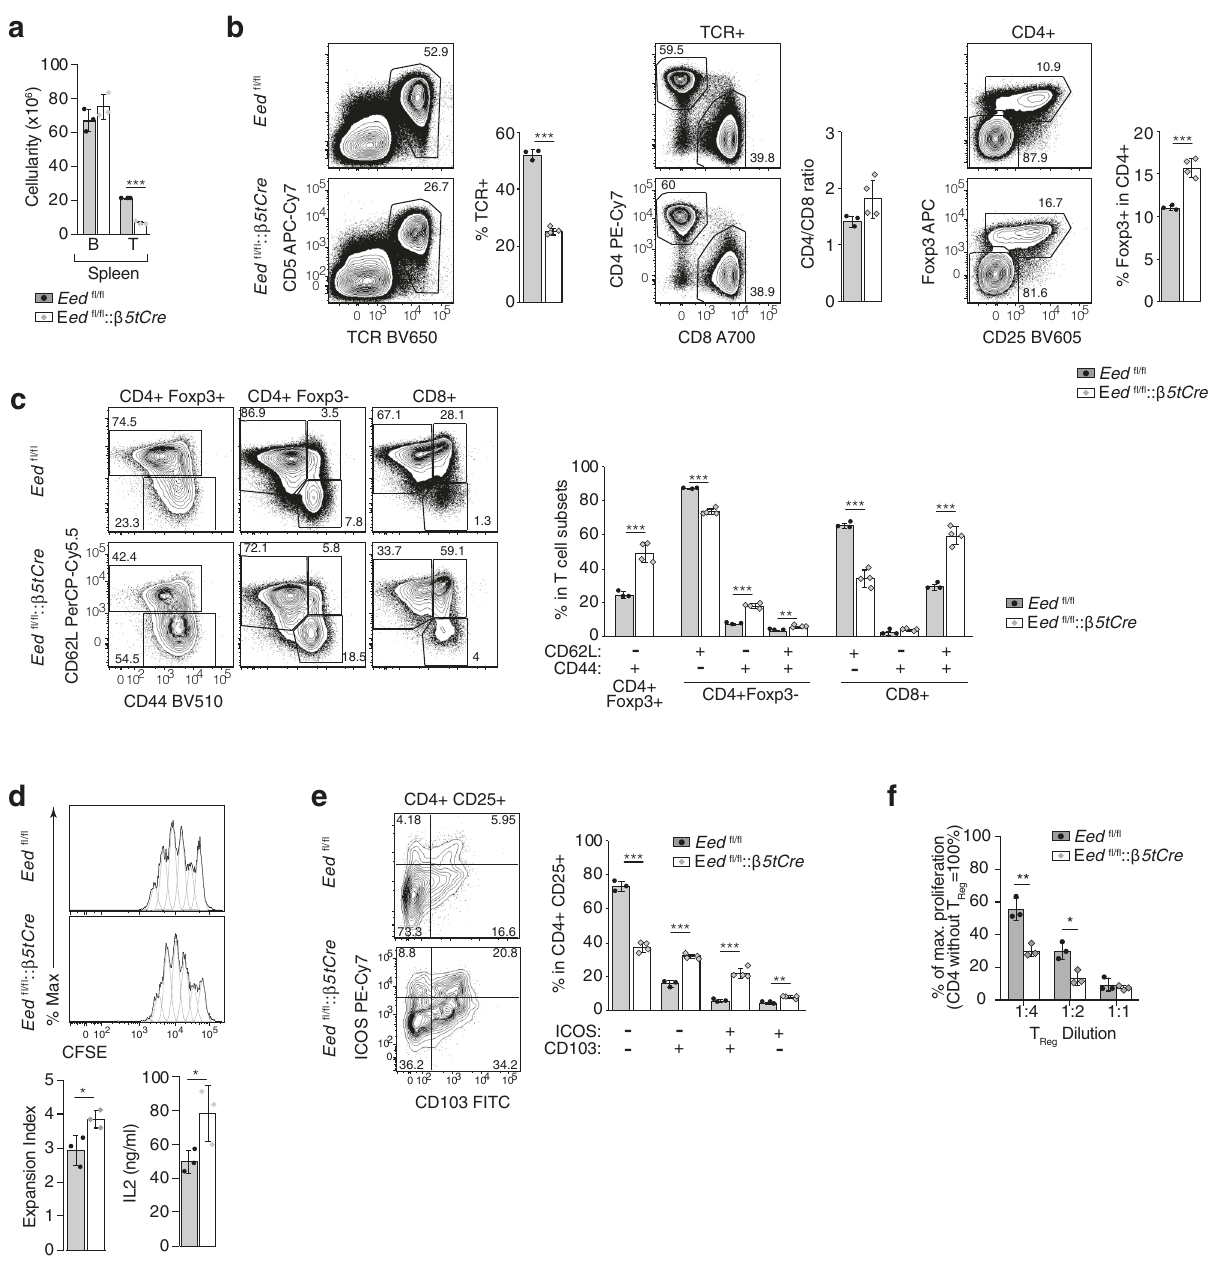
Fig. 6 Peripheral T cells and their function in Eed fl / fl :: β 5tCre and Eed fl / fl mice. a Absolute numbers of splenic B and T cells in Eed fl / fl ( n = 3) and Eed fl / fl :: β 5tCre mice ( n = 3) at 4 weeks of age. b Representative contour plots and frequencies of lymph-node-derived T cell subsets. Frequency of TCR β + T cells, the CD4/CD8 ratio within TCR β + T cells and percentage of Foxp3 + T Reg in CD4 T cells. c Frequencies of activated cells (CD44 + CD62L − ) in Foxp3 + T Reg and frequencies of naive (CD44 − CD62L + ), central memory (CD44 + CD62L + ) and effector memory (CD44 + CD62L − ) T cells within the populations of Foxp3 − CD4 and CD8 lymph node cells. b , c Eed fl / fl ( n = 3) and Eed: fl / fl : β 5tCre mice ( n = 4) at 4 weeks of age. d Proliferative response and IL-2 secretion of naive lymph node CD4 T cells (CD44 lo CD25 − ) from Eed fl / fl ( n = 3) and Eed fl / fl :: β 5tCre mice ( n = 3) at 4 weeks of age. Representative histograms of CFSE dilution (including model components used for expansion index calculations; grey dotted lines) following stimulation for three days with CD3 mAb (1 µ g/ ml) and irradiated Rag2 − / − splenocytes. Bar graphs display the mean expansion index (left) and mean IL2 concentrations in the supernatant (right) with SD. e Representative contour plots and frequencies of lymph-node-derived T Reg subsets de fi ned by their differential expression of ICOS and CD103 from Eed fl / fl ( n = 3) and Eed fl / fl :: β 5tCre mice ( n = 4) at 4 weeks of age. f T cell suppression assay: CD3 mAb-induced proliferation of sorted naive WT CD4 T cells (CD44 lo CD25 − ) in the presence of sorted lymph node Treg (CD4 + CD25 + ) from Eed fl / fl ( n = 3) and from pools of two Eed fl / fl :: β 5tCre mice each ( n = 3) of mixed sex at 7 – 9 weeks of age. * p < 0.05, ** p < 0.01, *** p < 0.001 (unpaired Student ’ s t test). Data in graphs show mean ± SD and are representative of two independent experiments. Contour plots ( b, c, e ) and histograms ( d ) are representative of data in bar graphs. Eed fl / fl :: β 5tCre : white bars with grey diamonds, Eed fl / fl grey bars with black circles. n = biologically independent replicates per group. Source data including exact statistical test values are provided in the Source Data fi